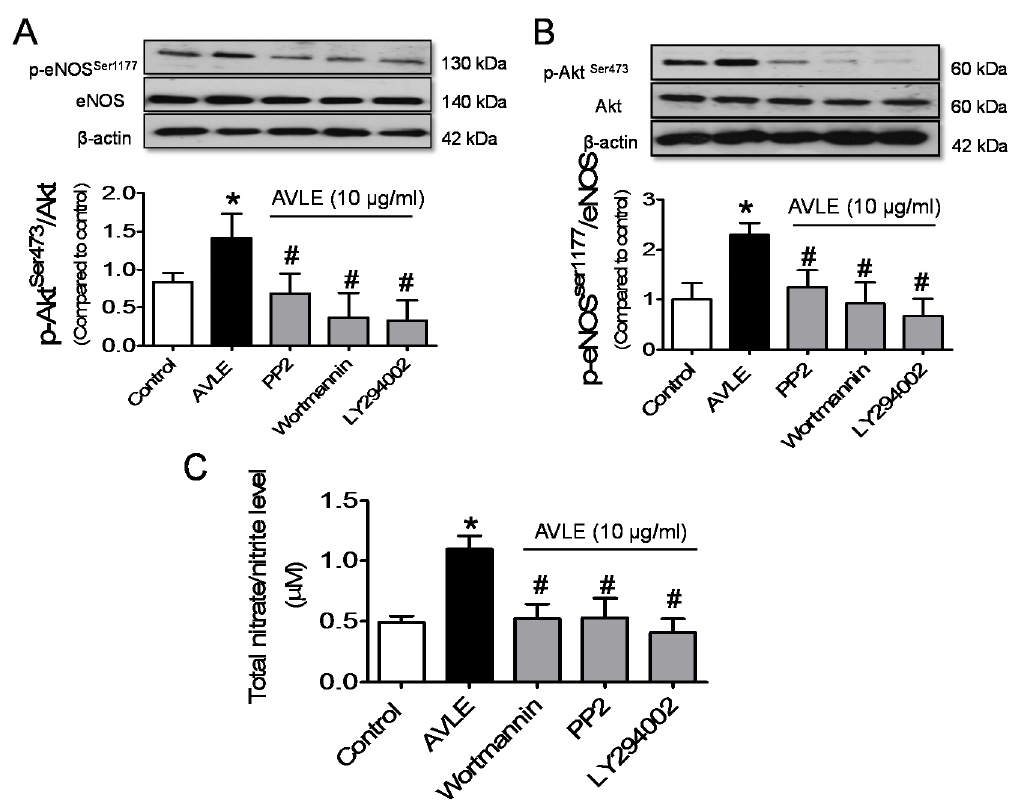
Figure 4. Pre-exposure with inhibitor of Src kinase, PP2 (20 µM) and PI3-Kinase inhibitors wortmannin (30 nM) and LY294002 (20 µM) for 30 min significantly down-regulated p-eNOS Ser1177 ( A ); and p-Akt Ser473 ( B ) protein expression; and ( C ) total nitrate/nitrite (NO x ) level induced by AVLE (10 µg/mL, 30 min) in HUVECs. Results are means ± SEM ( n = 3–5). * p < 0.05 compared to control, # p < 0.05 compared to AVLE.